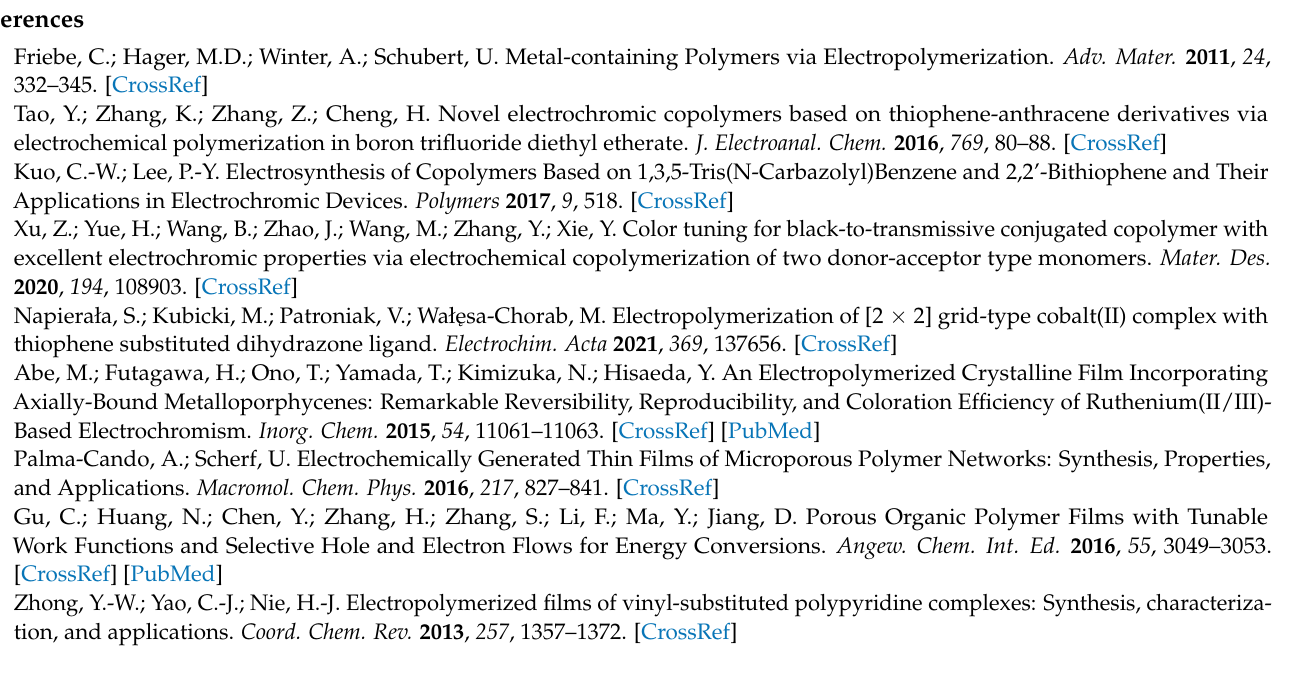
ESI-MS spectra of complex 2